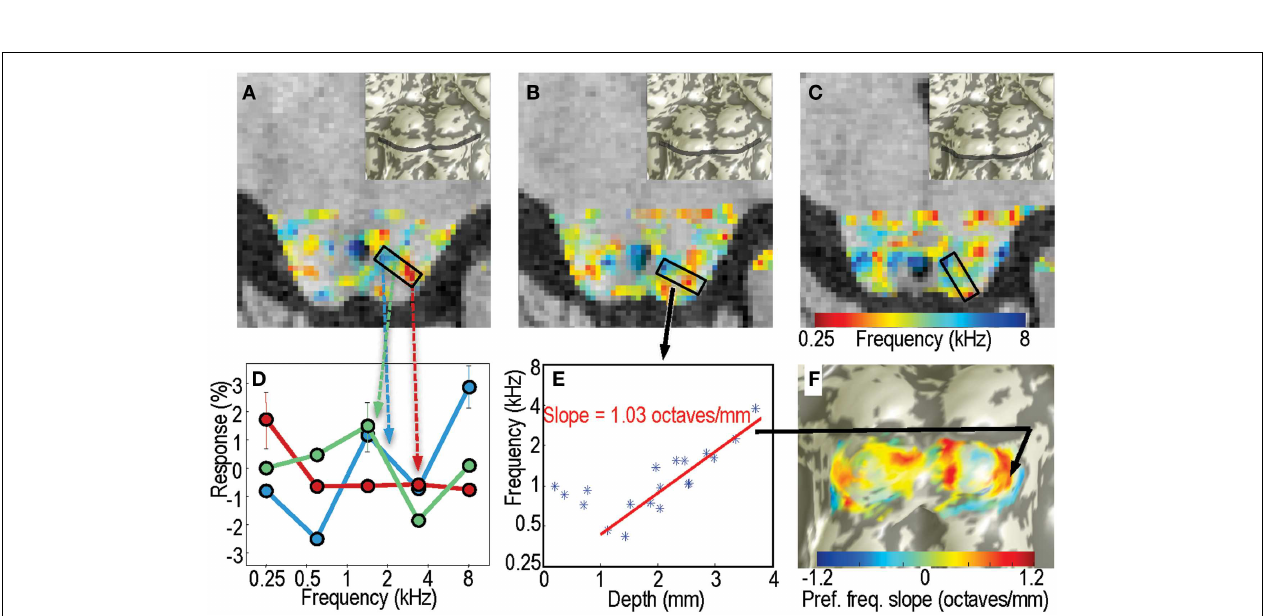
FIGURE 3 | Response differences between the highest and lowest frequency stimuli for subject 1 . (A–C) Response difference is shown as a color overlay upon axial high-resolution structural anatomy images of the IC.Transparency is modulated by statistical significance of the sound stimuli vs. quiet-periods. Insets show location of each slice on the IC surface model. (D) Responses as a function of depth to the lowest- (red) and highest-frequency stimuli (blue); difference is shown in black.These